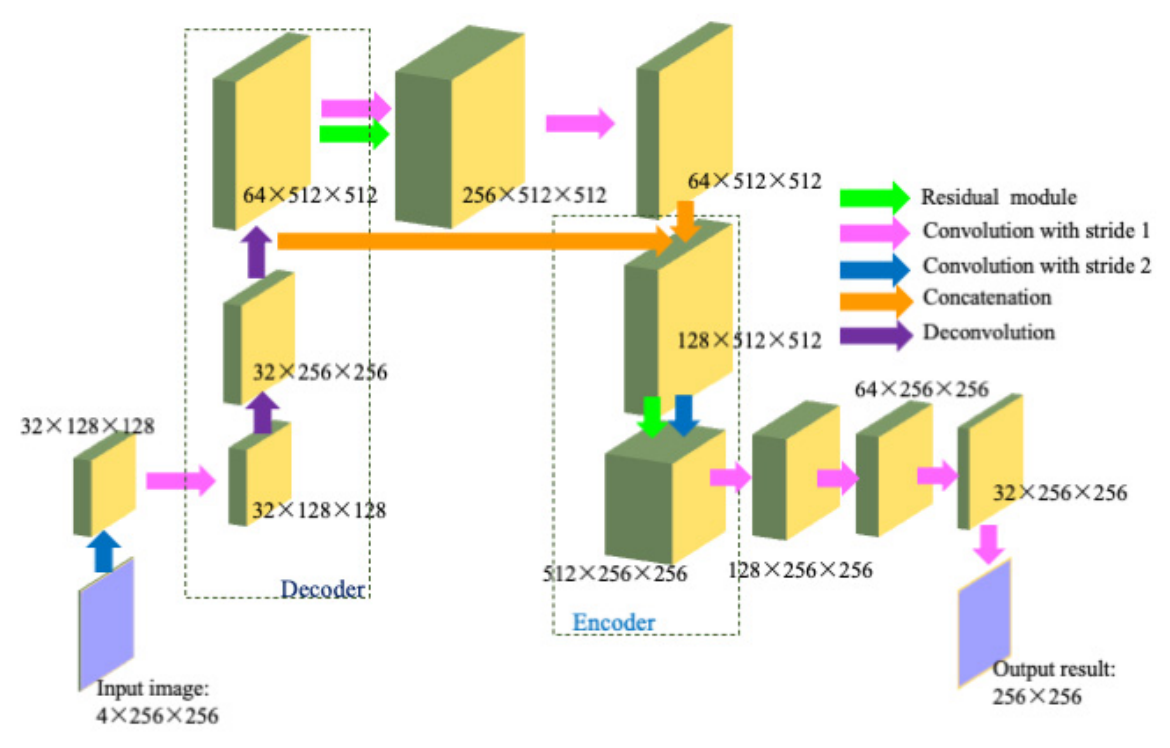
Figure 1. Architecture of the proposed DeenNet. The input image is a four-channel matrix with a size of 256 × 256 pixels, and the output image is a single-channel image with a size of 256 × 256 pixels.